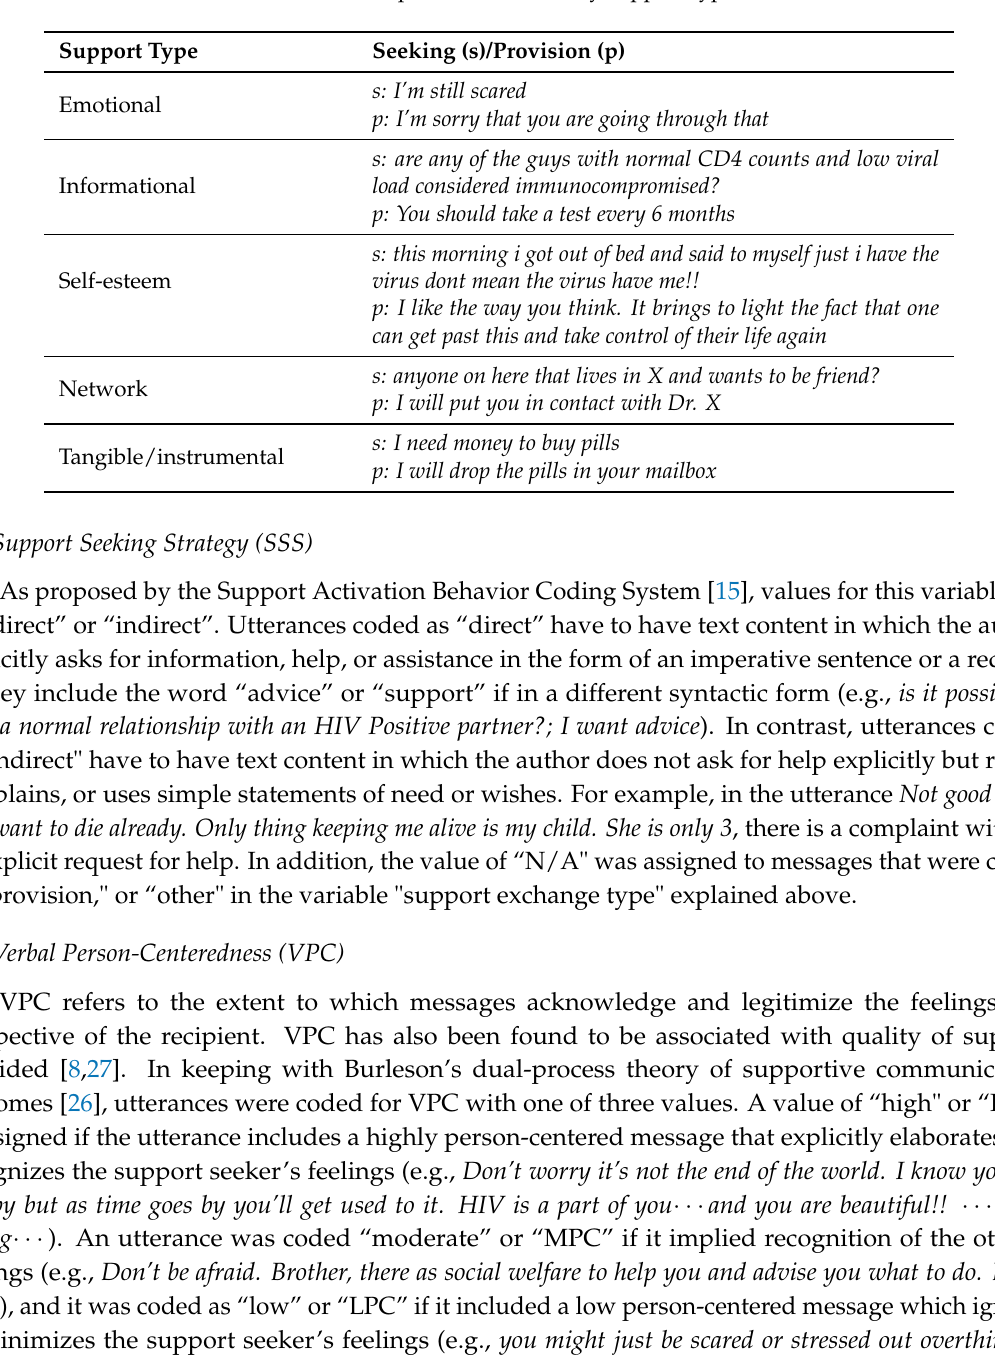
Table 4. Examples of utterances by support